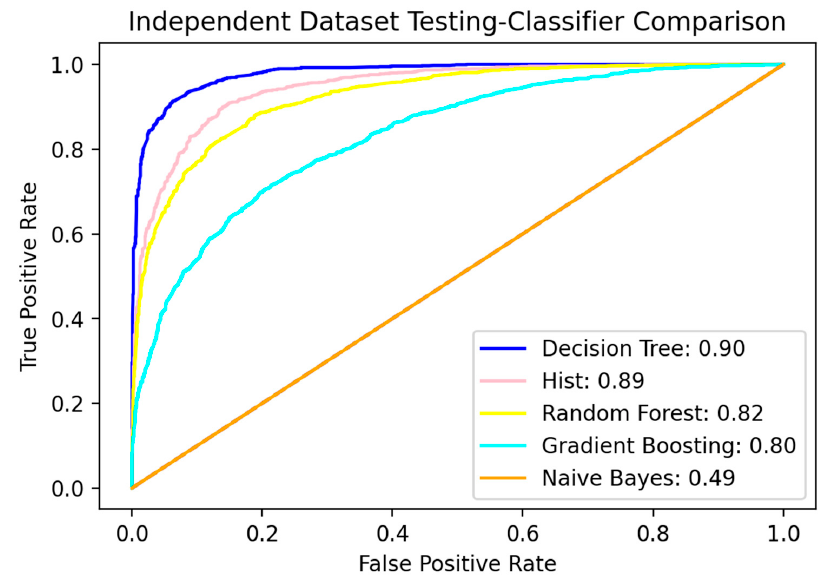
Figure 8. ROC curve of independent dataset test for all 5 classifiers.